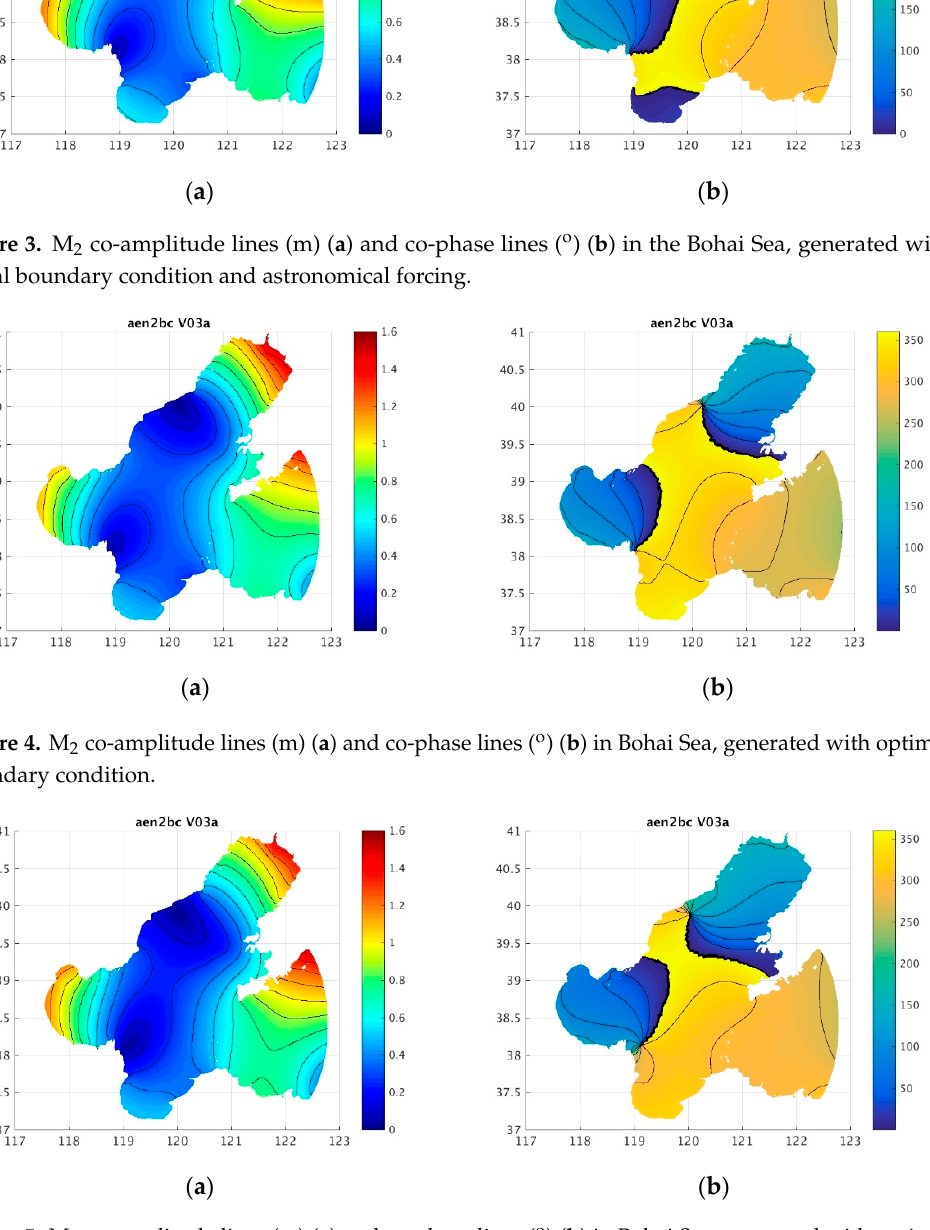
Figure 5. M 2 co-amplitude lines (m) ( a ) and co-phase lines ( o ) ( b ) in Bohai Sea, generated with optimal boundary condition and corrected tidal forcing.